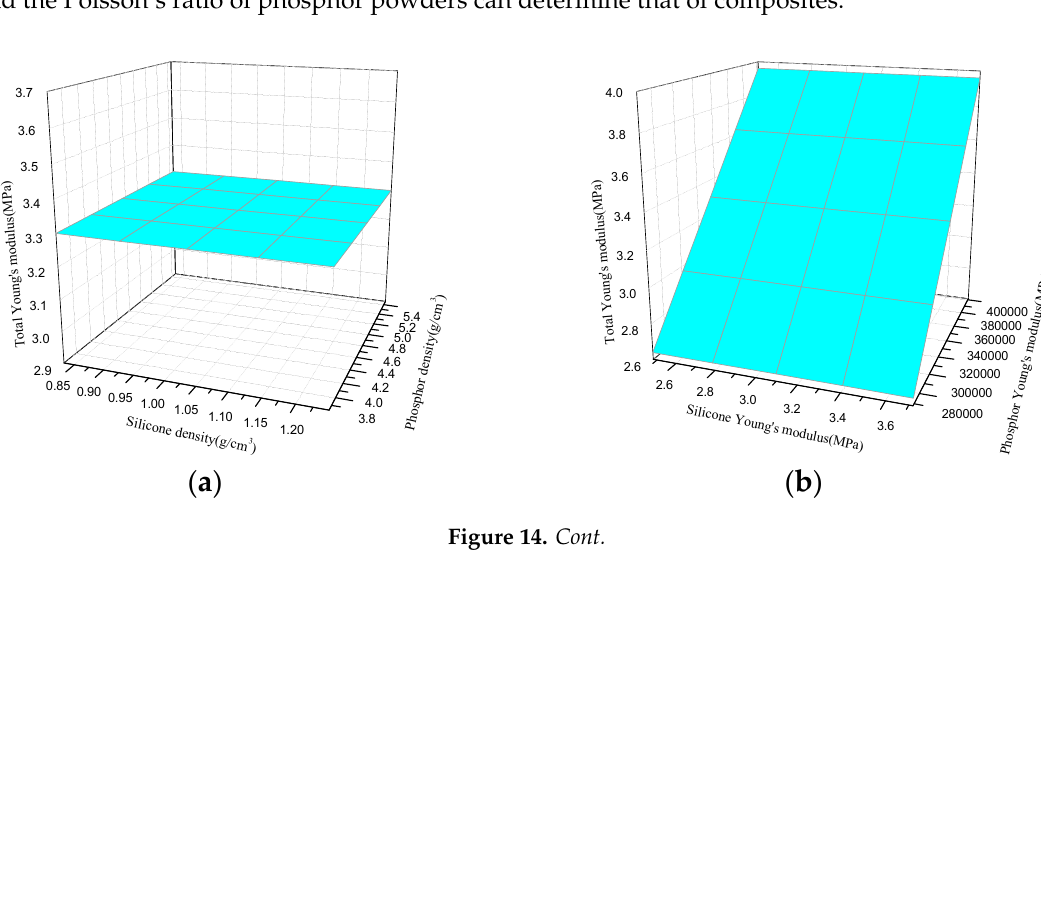
Figure 13. The tensile test results ( a ) Young’s modulus; ( b ) tensile strength. Due to the density, Young’s modulus and Poisson’s ratio of phosphor powders not being able to be accurately known during the ageing process, a sensitivity study was conducted in this section to quantitively evaluate the impact of component’s parameters on the Young’s Modulus of phosphor / silicone composites by using the FE simulation method. The simulation results are shown in Figure 14. It can be summarized from Figure 14a that the densities of both silicone and phosphor have less impact on the total Young’s modulus of composite. Figure 14b,c reveal that the Young’s modulus and the Poisson’s ratio of phosphor powders can determine that of composites.